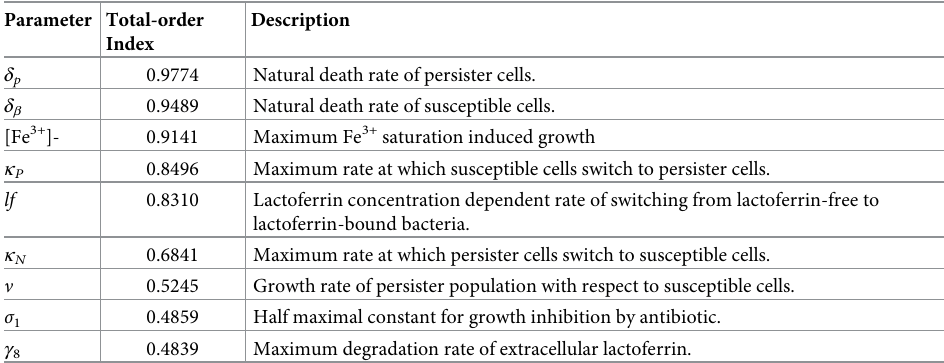
Table 2. Modal parameters with leading total-order sensitivity index values.